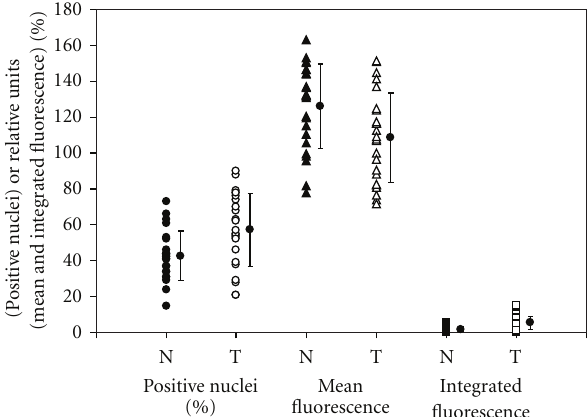
Figure 4: Ranges and means (asterisks, error bars indicate standard error) in immunofluorescence values for MGMT in normal (N) and tumour (T) tissue. Values for positive nuclei are shown as %, and for mean fluorescence and integrated fluorescence as relative